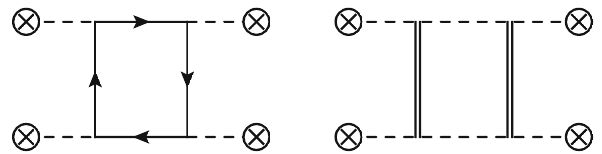
Fig. 4 Various diagrams containing divergences with four vertices. Here there are only two diagrams. The first one is purely matter, while the second one contains a quantum gravity correction. Both give cor- rections to the ϕ 4 coupling